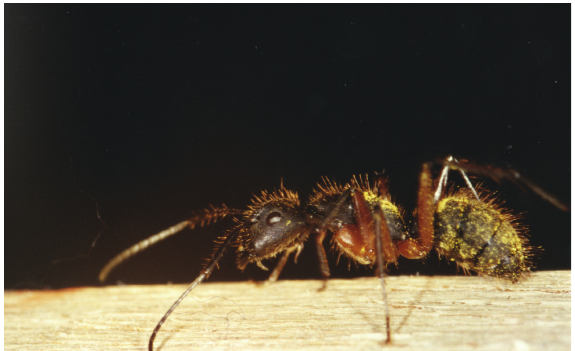
Figure 1: Worker of the nectar-feeding ant Camponotus rufipes, walking on a wooden stick to collect sugar solution from an artificial feeder. The ant was marked with yellow powder to allow for individual recognition (photograph by Helga